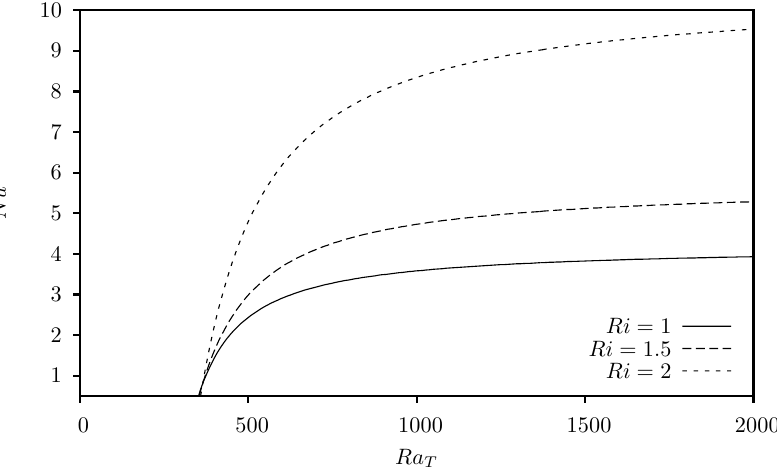
Figure 11. Variation of Nu with Ra T for steady nonlinear stability: effect of R i for Ra s = 250, Du = 0.05, Sr = 0.005, Le =